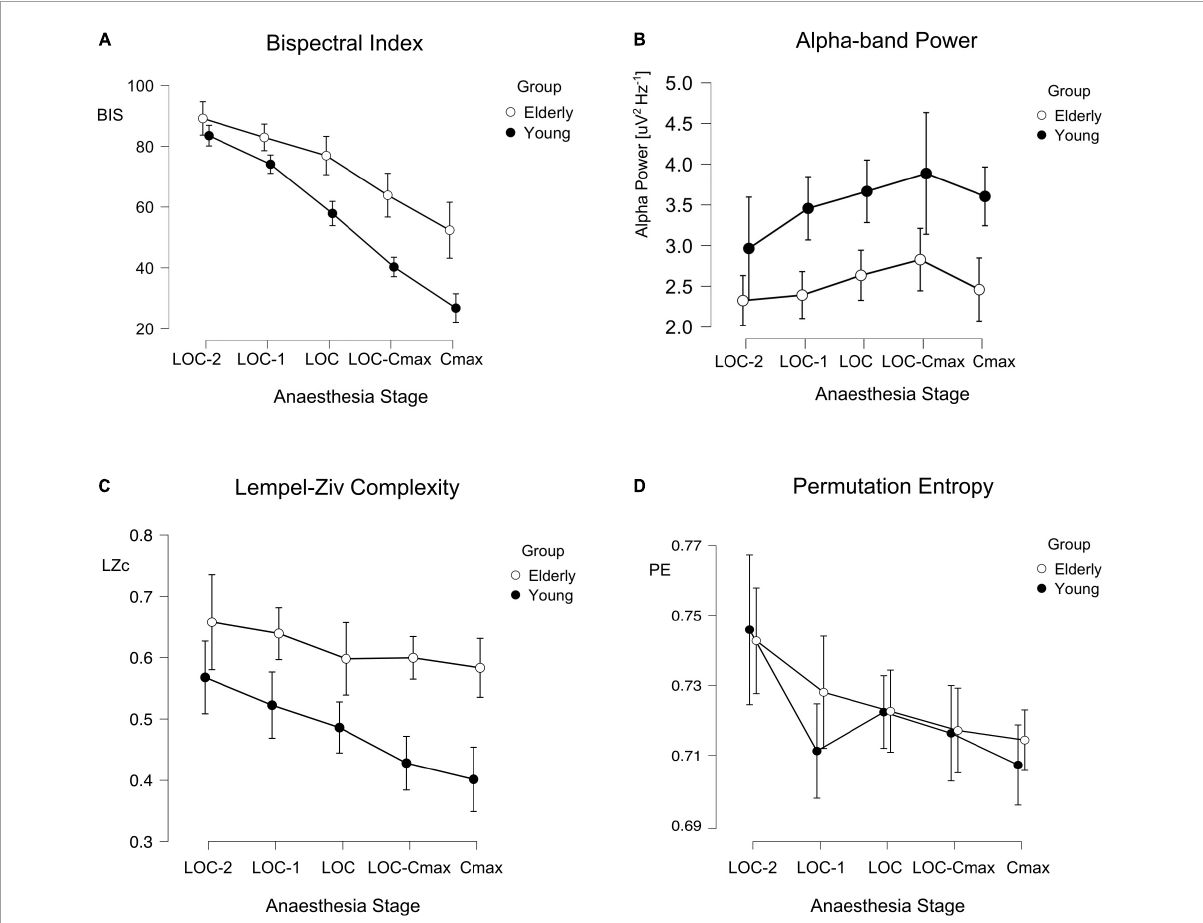
FIGURE2 BIS, Alpha, Lempel-Ziv complexity (LZc), and permutation entropy (PE) across anesthesia stages and age groups. Line plots depicting the different values of BIS (A) , Alpha Power (B) , LZc (C) , and PE (D) across anesthesia stages for young (filled circles) and elderly (empty circles) patients: Error bars represent the 95% confidence